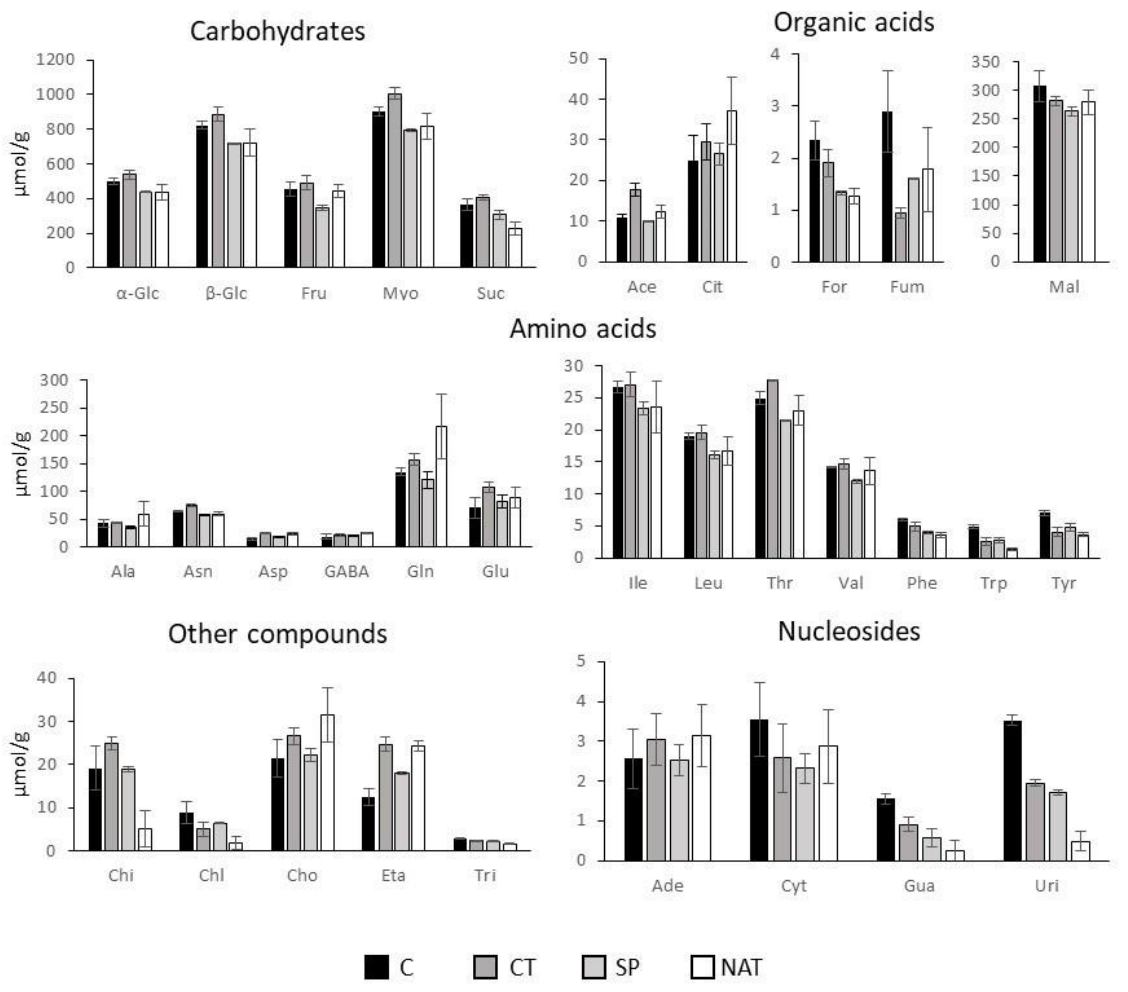
Figure 6. Absolute abundance (µmol/g dry leaves) of the metabolites identified by 1 H-NMR in L. sativa leaves extracts. Displayed data refers to the mean and standard deviation of three replicates. The vertical bars represent the four treatments: C = control; CT = compost T, SP = spirulina, NAT = spirulina + Fusarium DNA.